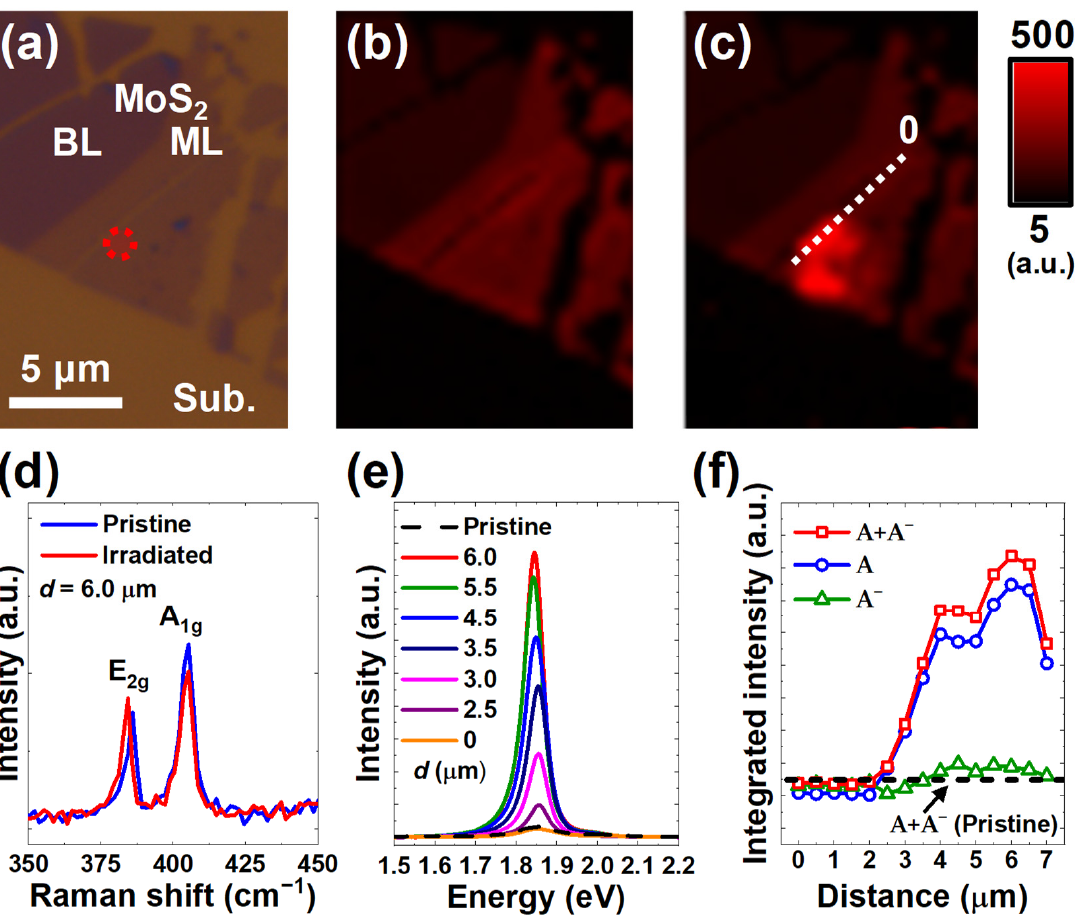
Figure 3. Local modulation of ambient PL intensity of ML-MoS 2 irradiated area selectively using the focused laser beam: ( a ) An OM image of the ML-MoS 2 flake, including the red dashed circle, indicates the spot for the selective FLI process on the ML region. The maps of the total integrated PL intensity, I Total , obtained from the ML-MoS 2 ( b ) before and ( c ) after the FLI process. ( a – c ) are presented in the same scale, and ( b , c ) are drawn in the same color scale for the integrated PL intensity. ( d ) The Raman spectra were measured before and after the FIR process at d = 6.0 µ m near the irradiation center. The parameter d is the distance from the origin 0 to a measured spot along the white dashed line in ( c ). ( e ) A series of representative ambient PL spectra were measured by moving the focused-laser spot from the origin 0 to the spot of d = 7.0 µ m across the irradiated region. ( f ) The variation in the integrated PL intensities of A and A − peaks, I A and I , and their sum, I , with d . For a A − A + A − comparison, ( e , f ) include the data measured from the pristine ML-MoS 2 before the FLI